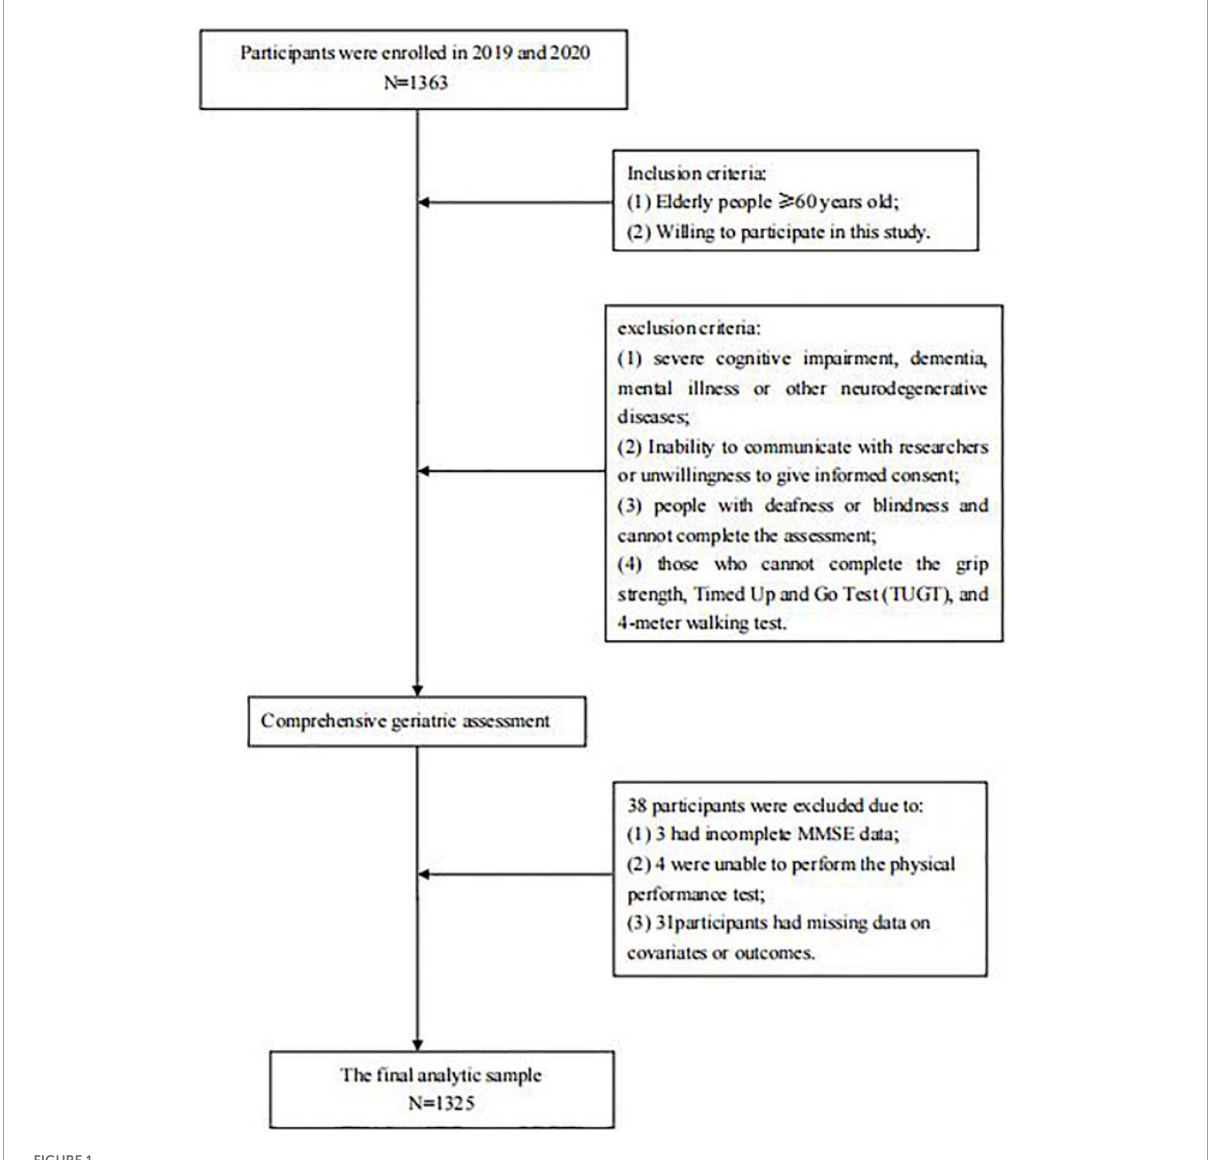
FIGURE1 Flow chart of the